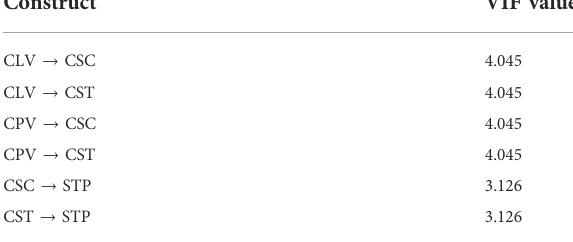
TABLE 4 Discriminant validity. TABLE 5 Inner VIF